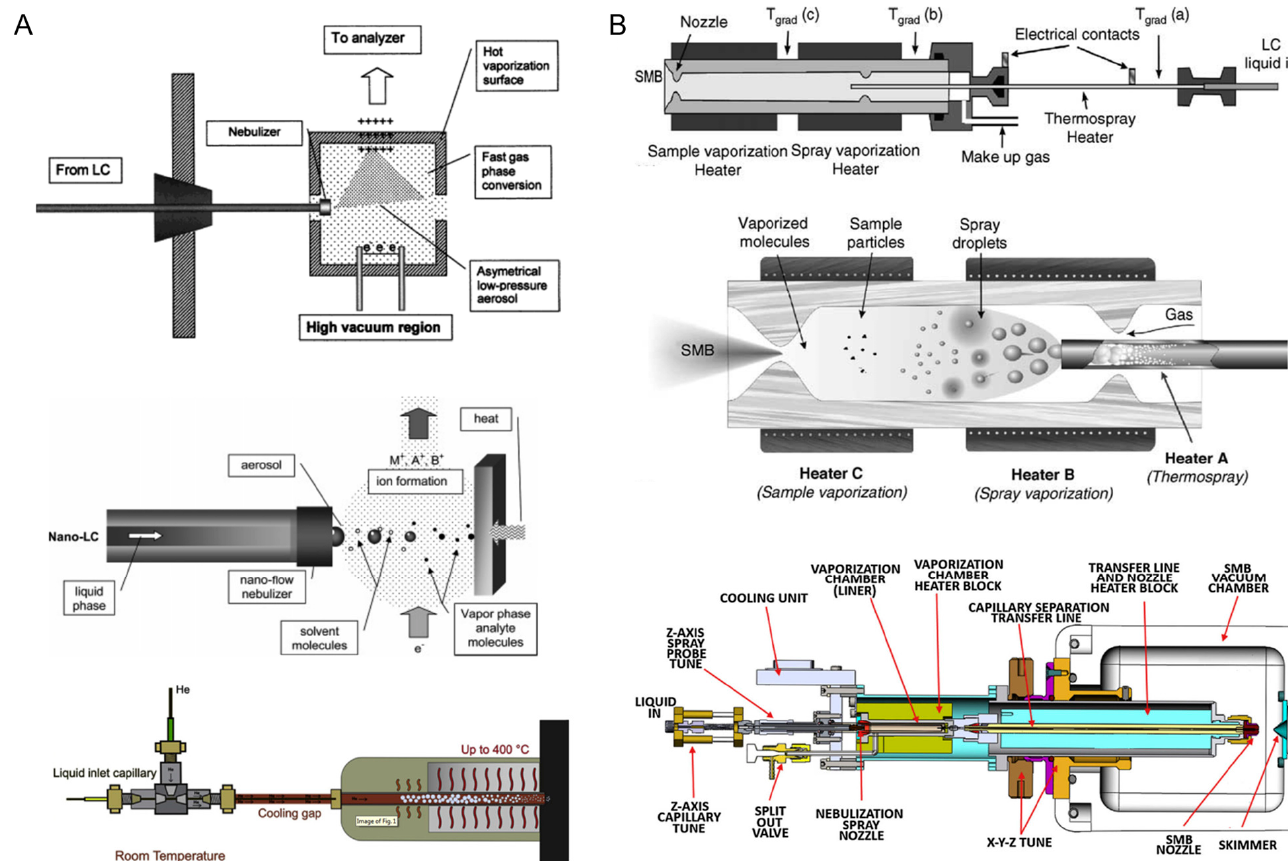
Figure 1. ( A ) Schematic of several versions of a direct EI interface for LC-EI-MS. ( B ) Schematic of two versions of supersonic molecular beam LC-EI-MS interfaces [27]. Adjusted and reprinted with permission from Elsevier.